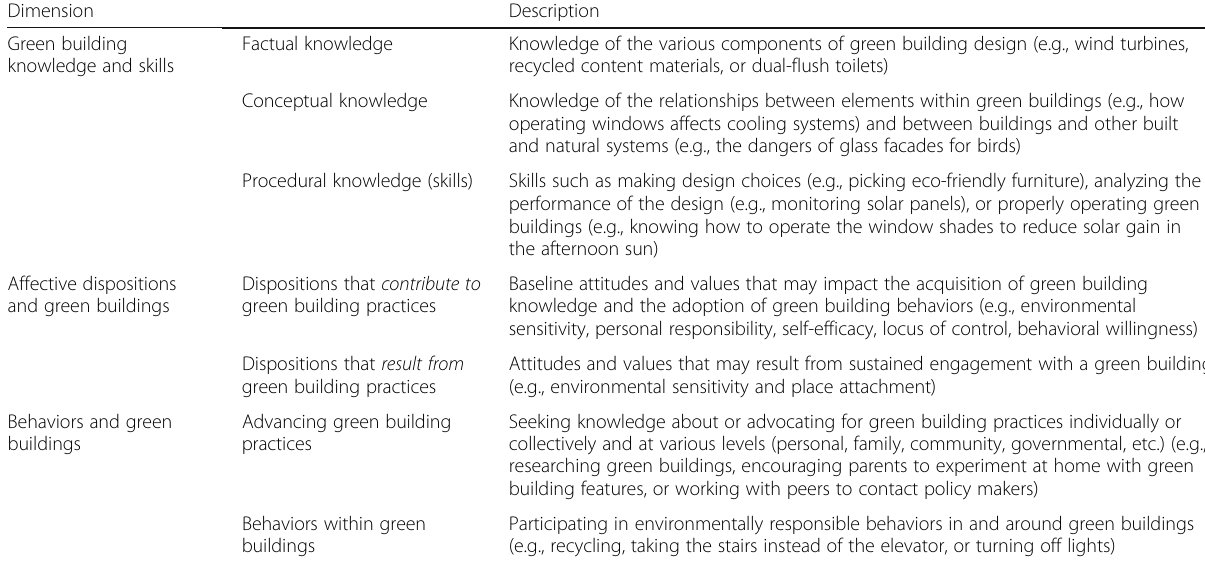
Table 1 Major features of green building literacy